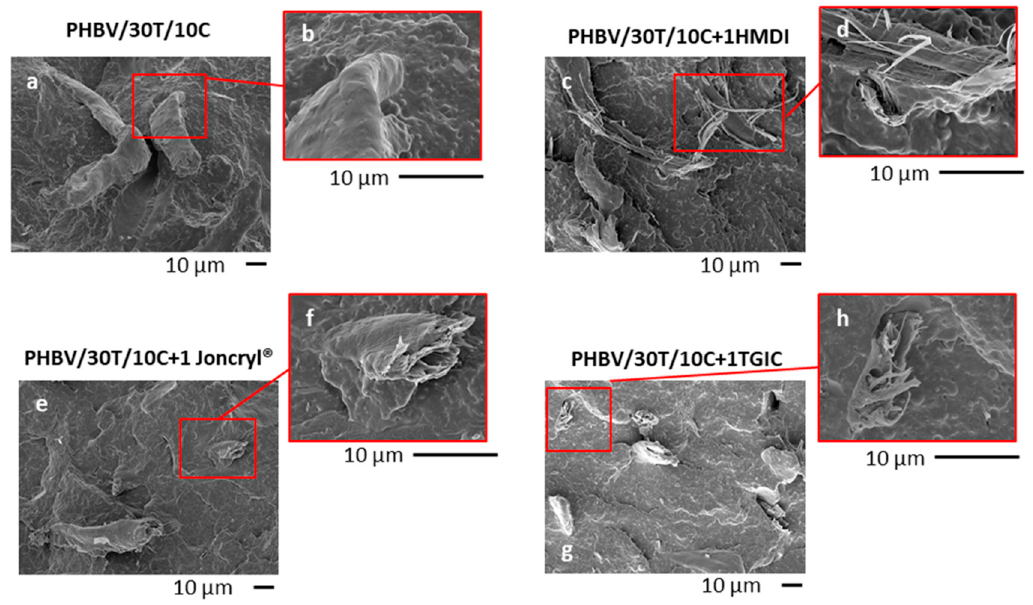
Figure 3. SEM micrographs of PHBV/30T/10C ( a , b ) and PHBV/30T/10C with 1 phr of HMDI ( c , d ), Joncryl ® ( e , f ), and TGIC ( g , h ). Int. J. Mol. Sci. 2018 , 19 , x FOR PEER REVIEW